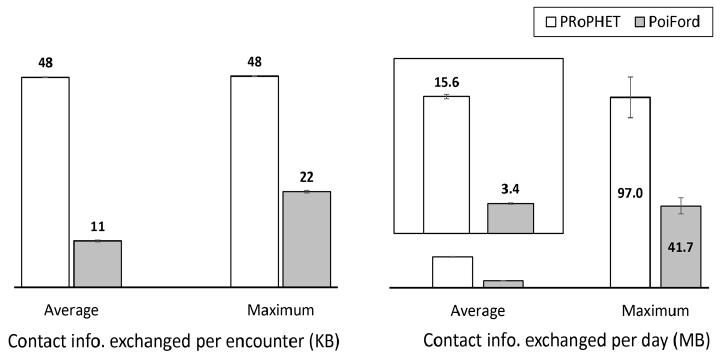
Figure 5. The size of contact information that nodes exchanged when running on PRoPHET and PoiFord.